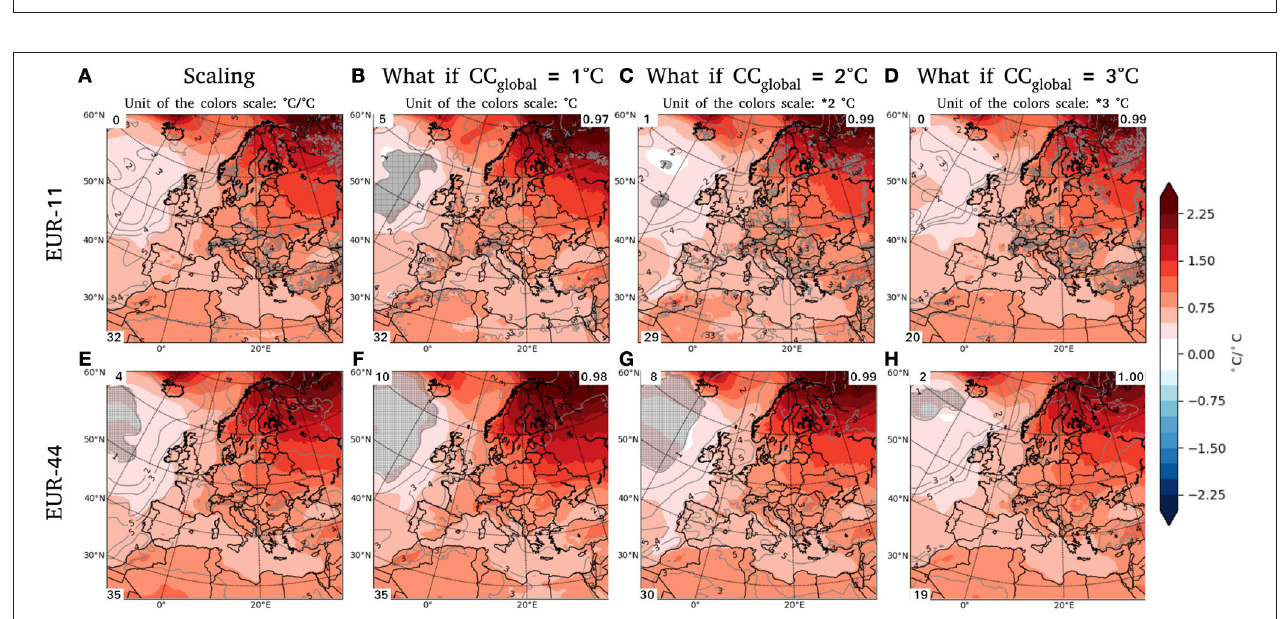
FIGURE 9 | JJA precipitation. Specifications and conventions as in Figure 8 .